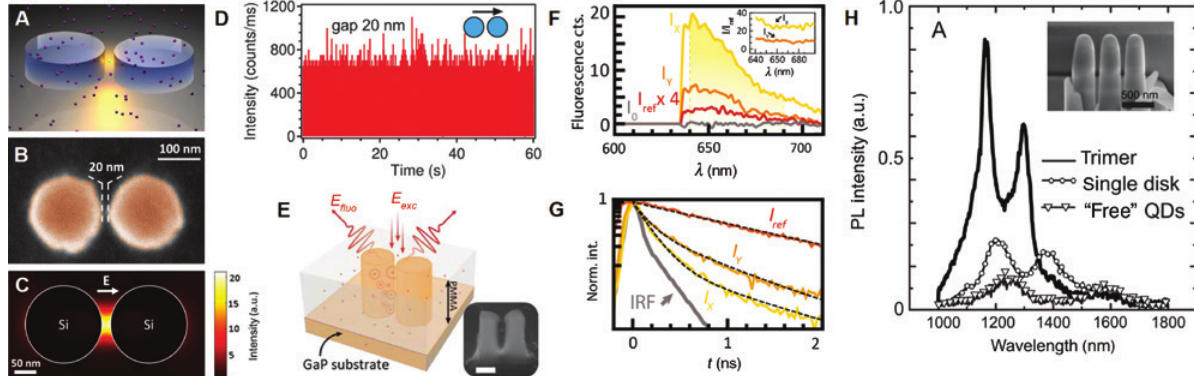
Figure 17: Coupling of emitters to single dielectric Mie resonators. (A) Sketch of a silicon nanogap antenna to enhance fluorescence from single molecules diffusing in solution. (B) Scanning electron micrograph of a fabricated silicon dimer with a gap size of 20 nm. (C) Numerically simulated electric field intensity enhancement in a horizontal plane through the center of the silicon dimer for normally incident light impinging from the glass substrate side, which is polarized parallel to the dimer axis. (D) Fluorescence intensity time trace showing bursts from single crystal violet molecules, which indicate fluorescence enhancement by the silicon nanogap antennas. (A–D) reprinted with permission from [147]. Copyright (2016) American Chemical Society. (E) Scheme of experimental configuration of GaP nanodimers embedded in a dye-doped PMMA layer. The inset shows a scanning electron micrograph of a fabricated GaP dimer with 35 nm gap size (scale bar: 100 nm). (F) Fluorescence spectra from the PMMA/ dye-coated GaP nanodimer for the excitation polarized parallel ( I ) and perpendicular ( I ) to the dimer axis. For reference, fluorescence X Y spectra from a region of dye molecules not interacting with the nanoantenna ( I ) and from bare PMMA/GaP ( I ) are also included. ref 0 (G) Fluorescence intensity decay curves for the PMMA/dye-coated GaP nanodimer. The instrument response function (IRF) is shown for reference. (E–G) reprinted with permission from [235]. Copyright (2017) American Chemical Society. (H) PL spectra of a Ge QD containing trimer (solid black line), of a single Ge QD containing nanocylinder (circles), and of the corresponding reference Ge(Si) QDs